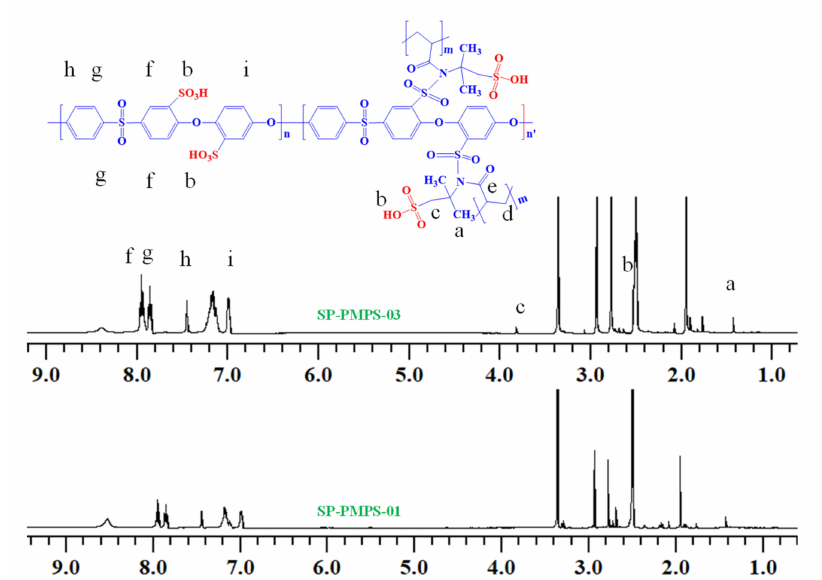
Figure 2. Nuclear Magnetic Resonance ( 1 H-NMR) spectra of synthesized SP-PMPS membranes. The signals related to SP-PMPS has been indicated in form of lowercase letters and defined in the manuscript with their corresponding